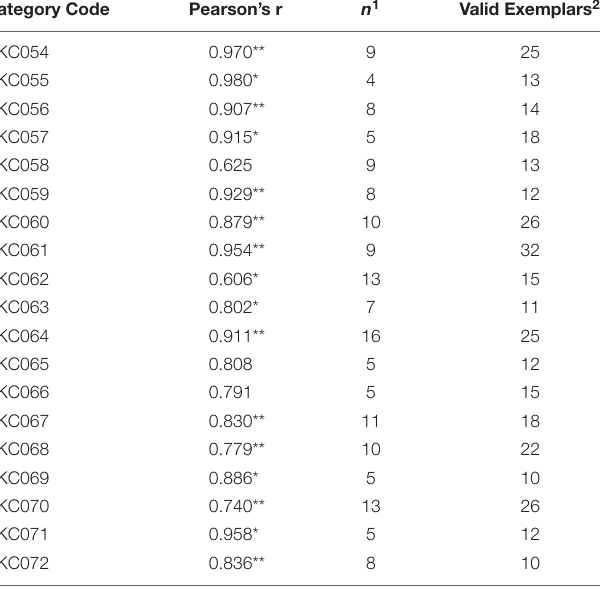
TABLE 2 | Total-Slot1 correlations on all categories. Category